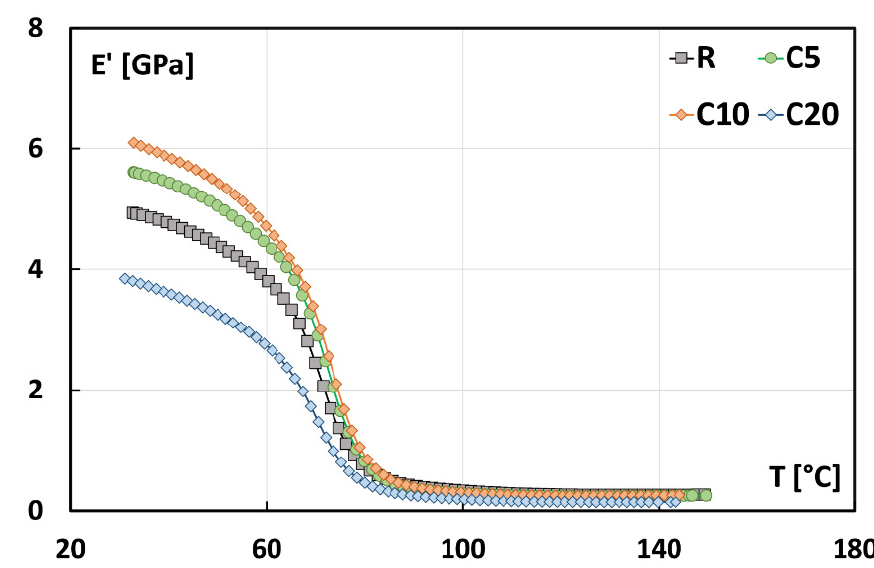
Figure 7. Typical storage modulus E’ trends of flax fiber reinforced composites. Further information about the interfacial bonding between flax fibers and epoxy matrix can be acquired by analyzing the damping factor (i.e., tan δ ) trends of composites shown in Figure 8. Damping factor is calculated as the ratio between loss modulus E” (representing the material tendency to dissipate the applied energy) and storage modulus E’. The shape of tan δ curves is strictly affected by the quality of the fiber–matrix interfacial bonding [37]. In particular, weak fiber–matrix interfaces lead to higher damping factor values. Conversely, a stronger adhesion limits the polymer chains mobility and, as a consequence, reduces the damping also shifting the Tg to higher values [38,40,41].